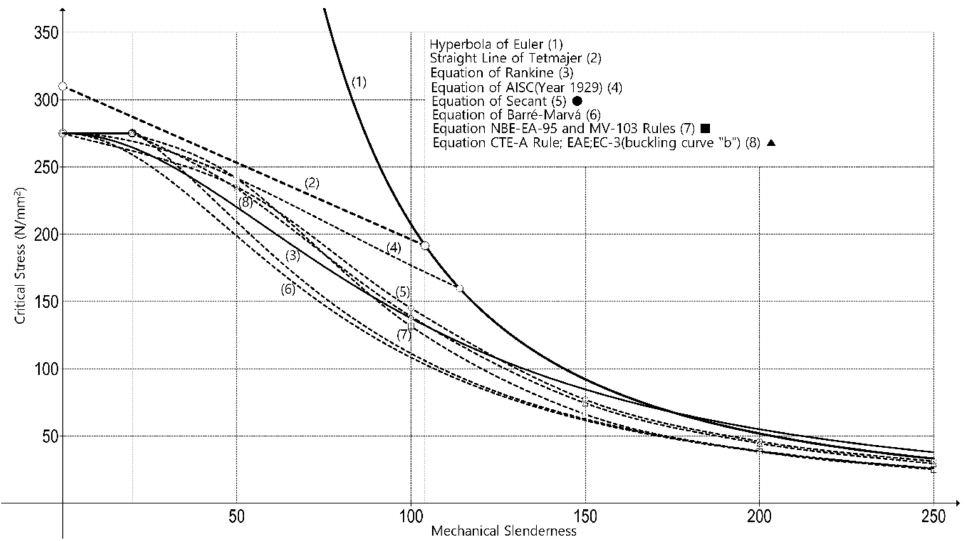
Figure 4. Strength–mechanical slenderness graph. Comparison between past and current models for slender steel col- umn